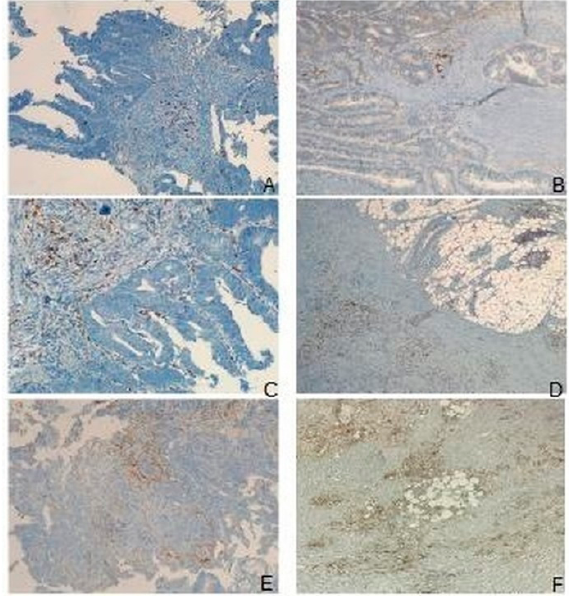
Figure 5. Modulation of TME in IN patients. Lower levels of infiltrating CTL and TH in the biopsy ( A ) than in the surgical sample ( B ); M2 macrophages ( C ) reverted to M1 in surgical sample ( D ). Higher expression of PD ‐ L1 ( E ) in biopsy than in operatory specimen ( F ). ( A – F ), immunohistochemistry: ( A , B ): CD4/CD8 double stain; ( C , D ): CD68; ( E , F ): PD ‐ L1; Original magnification (O.M.): ( A , C – F ): 10×; ( B ): 4×.